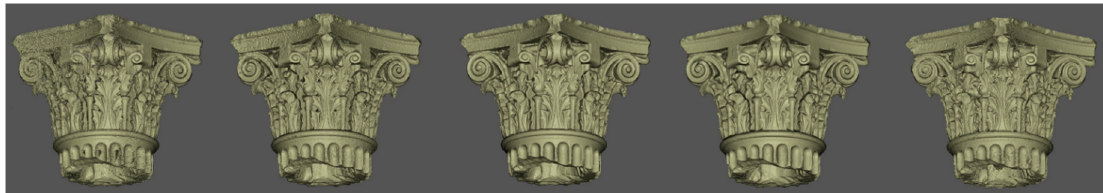
dataset 2 AMP, dataset 2 FZA, dataset 3 AMP, dataset 3 FZA.